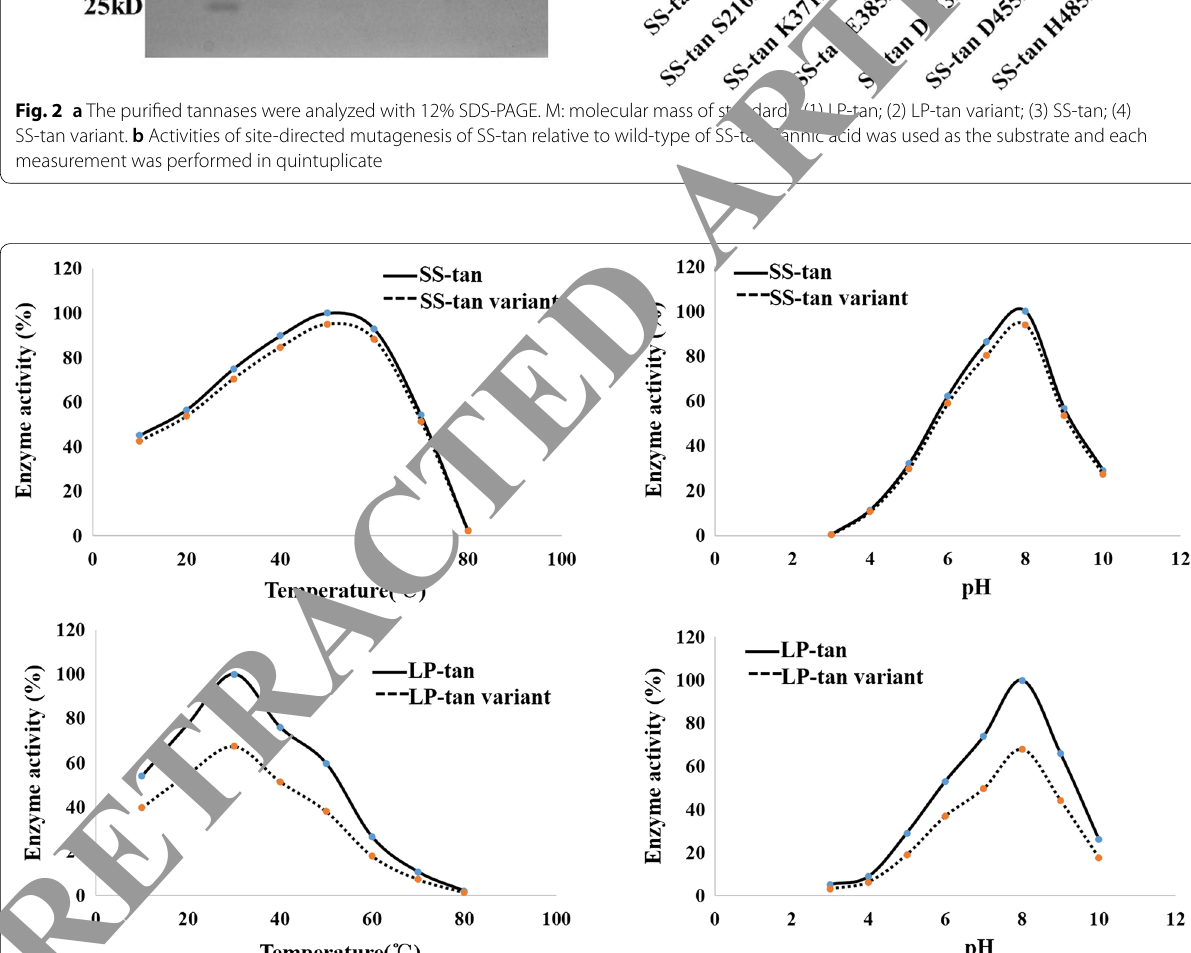
Fig. 3 Effects of pH and temperature on the activities of LP-tan variant and SS-tan variant. In all the cases the observed maximum activity was defined as 100% and each experiments were performed in quintuplicate. Methyl gallate was used as the